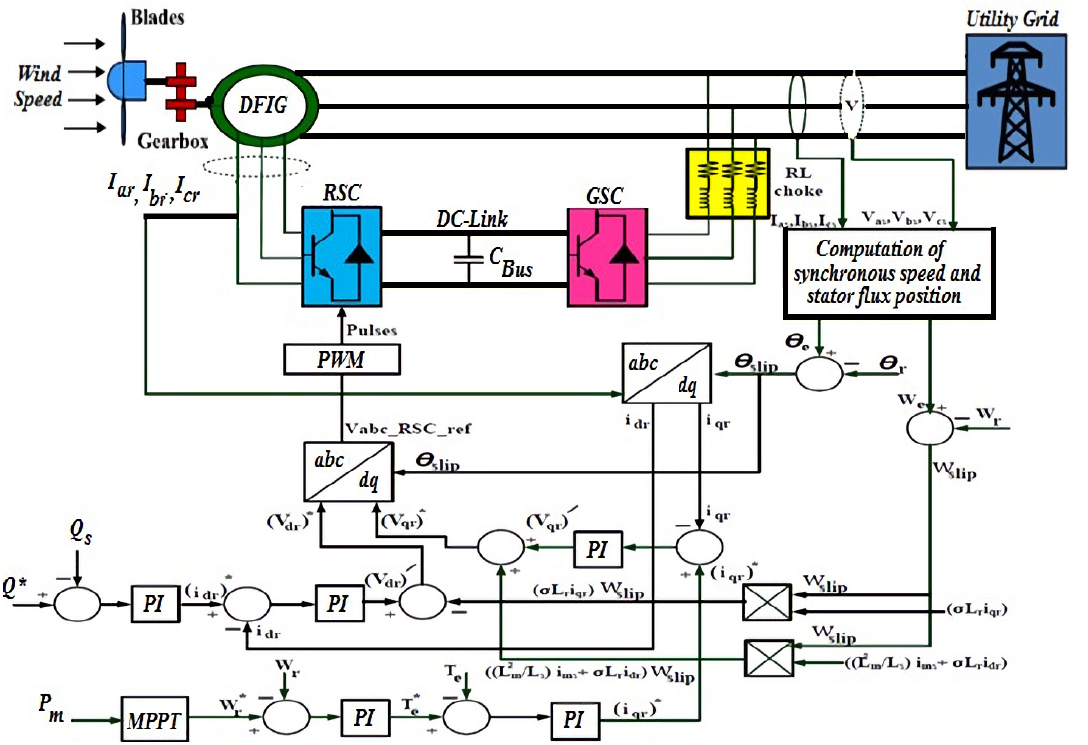
Figure 10. Schematic diagram control for RSC.